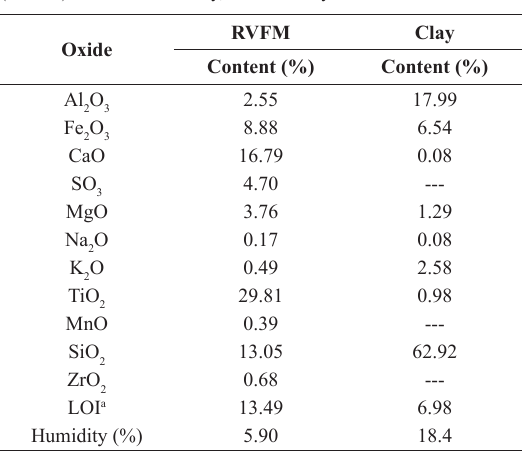
Table 3. Chemical composition of rotary-vacuum-filter mud (RVFM) and kaolinitic clay, estimated by